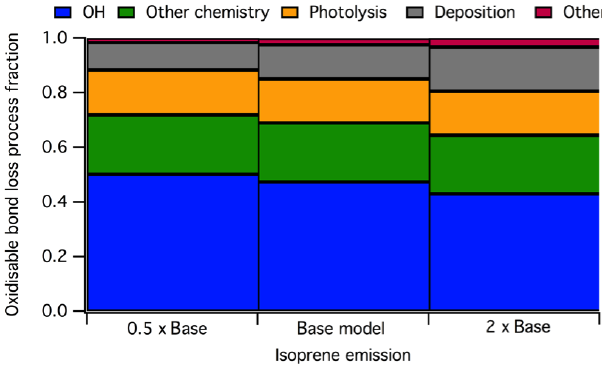
Figure 10. Oxidisable bond loss mechanism fractions under chang- ing isoprene